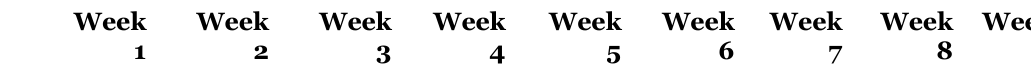
The Number of Posts and Posters in Every Subsequent Week of the Course